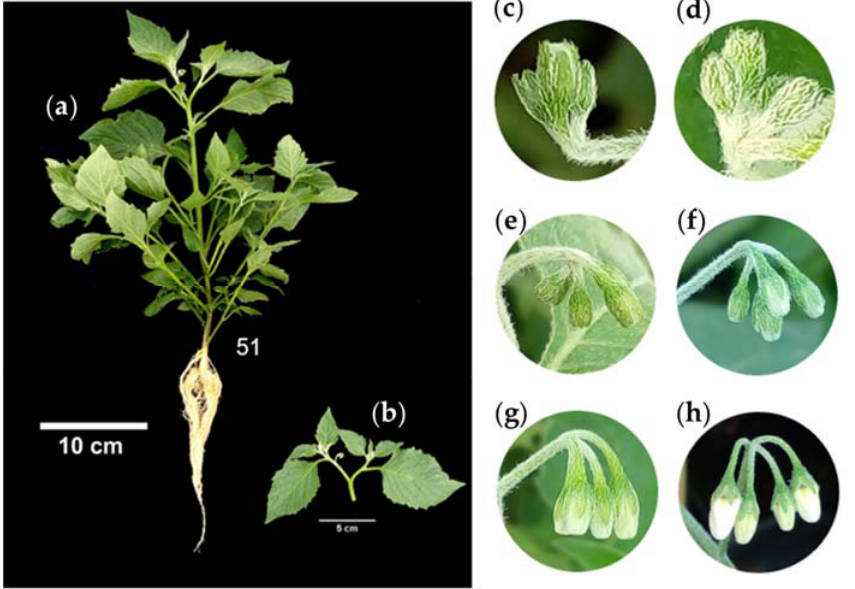
Figure 8. Inflorescence emergence ( a ), bifurcation of the main shoot ( b ), erect flower buds ( c ), and free buds ( d ) at level with the leaves ( e ), with 40% of the petals visible ( f ), 70% of the petals visible ( g ), and the sepals completely opened and with petals completely visible ( h ) in slender nightshade plants ( Solanum nigrescens ). Photos by Sara Monzerrat Ramírez-Olvera.